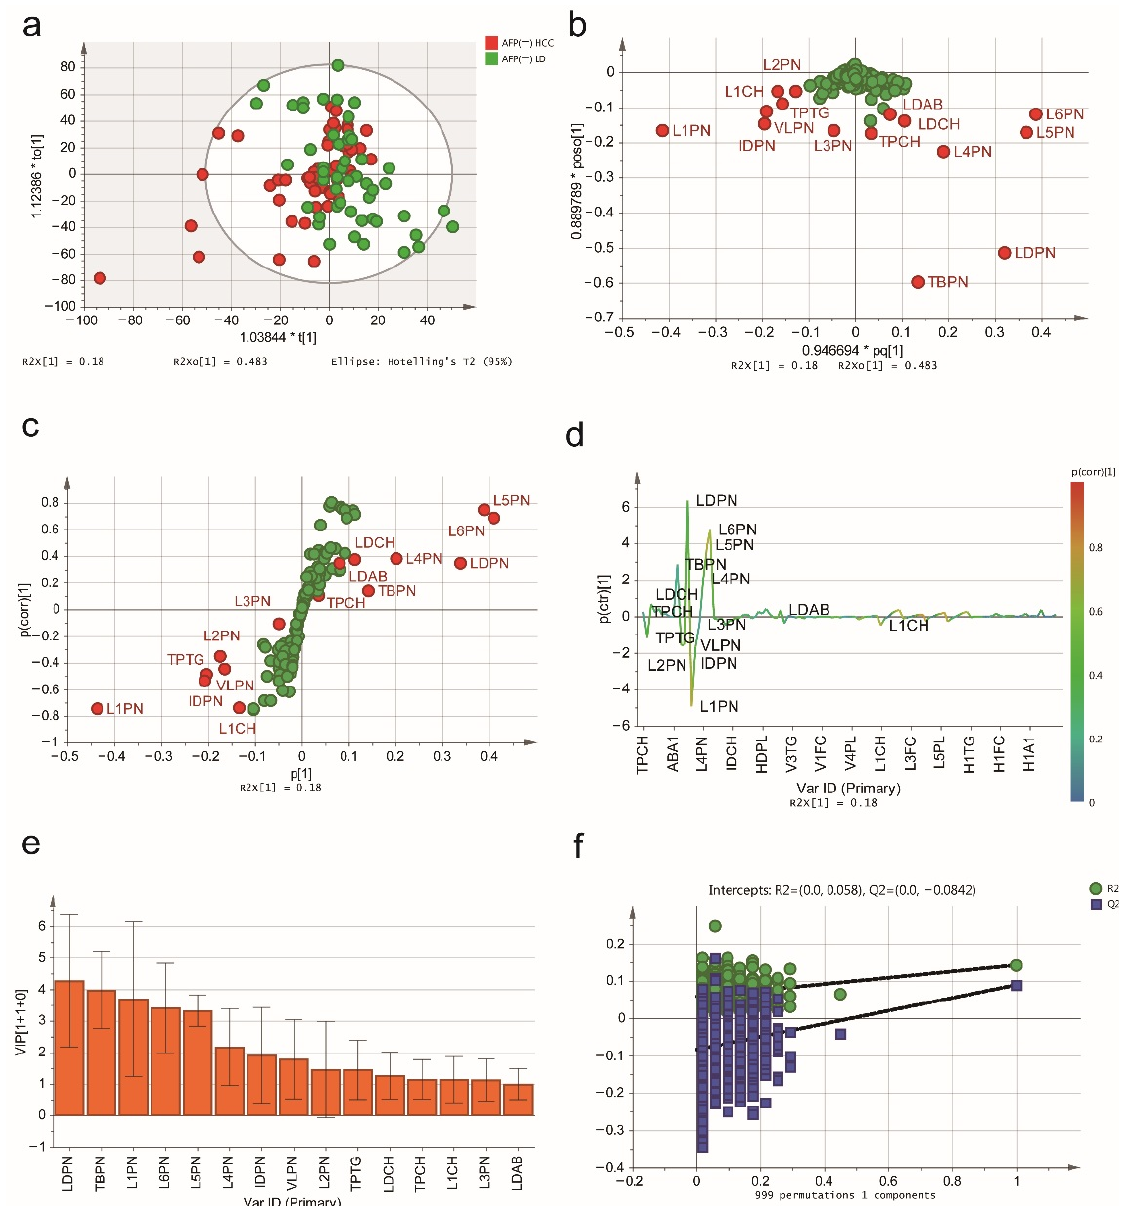
Figure 4. The serum lipidomic profile discriminates between AFP-negative HCC patients and AFP-negative LD patients. ( a ) Score plot was generated by the OPLS-DA model. The horizontal coordinate (1.03844 * t [1]) represents the score value of the main component, and the vertical coordinate (1.12386 * to [1]) represents the score value of the orthogonal component. ( b ) Loading plot was generated by the OPLS-DA model. The horizontal coordinate (0.946694 * pq [1]) represents the predicted principal component, and the vertical coordinate (0.889789 * poso [1]) represents the orthogonal principal components. The corresponding ( c ) S-plot and ( d ) S-line plot for the model displaying the discriminant variables and the associated predictive loadings. The red circles indicate selected lipoprotein subfractions with VIP scores >1.0, and other variables with no difference are referred to as green circles in ( b , c ). ( e ) The selected lipoprotein subfractions with VIP scores >1.0. ( f ) Permutation test (999 times) of the OPLS-DA model.